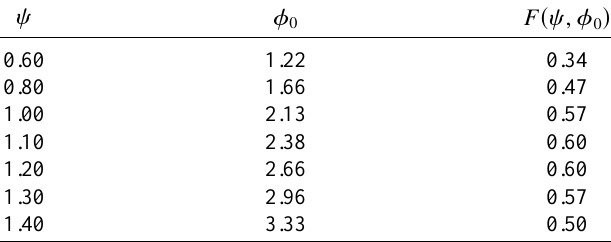
TABLE IV. Separatrix parameters from 1D theory.